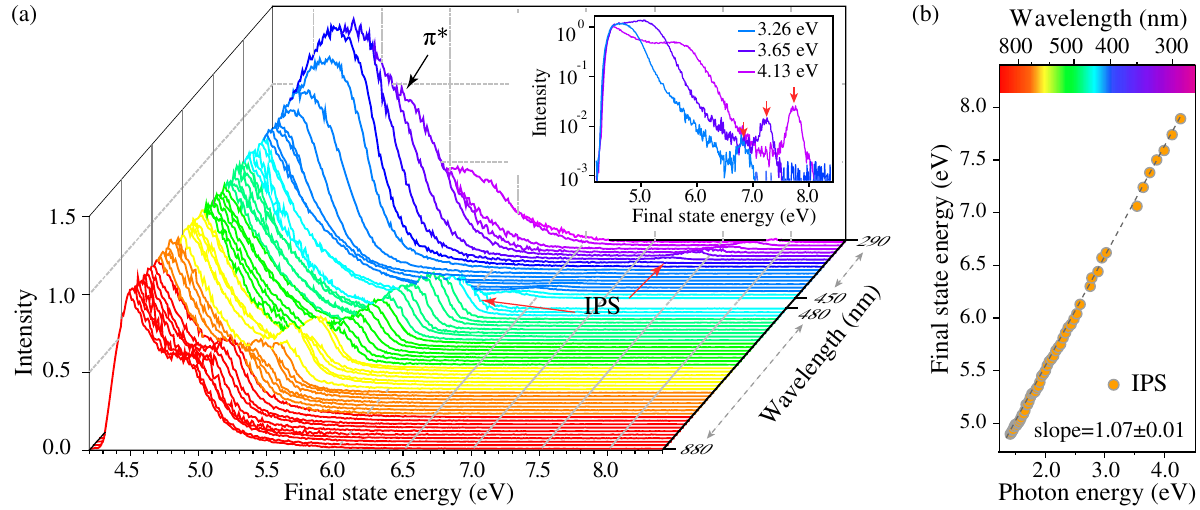
FIG. 2. (a) A series of mPP spectra of graphite for p -polarized excitation taken in 10-nm intervals from 880 to 290 nm ( h ν ¼ 1 . 41 – 4 . 28 eV; there is a tuning gap between 480 and 450 nm), which are obtained by taking k ∥ ¼ 0 cross sections through E ð k Þ distributions such as in Fig. 1(c). The spectra are normalized at the work-function maximum (4.5 eV). Red arrows point to the IPS peak. The inset shows several spectra with UV excitation on a log-vertical scale to emphasize the weak signal from IPS. Above h ν ¼ 2 . 95 eV, there is an additional component due to the indirect excitation from the π band. (b) A plot of the IPS final-state energy vs the photon energy, h ν . The slope (1.07) and intercept (3.6 eV) identify the IPS as the penultimate state in mPP at 0.8 eV below E v or 3.6 eV above E F